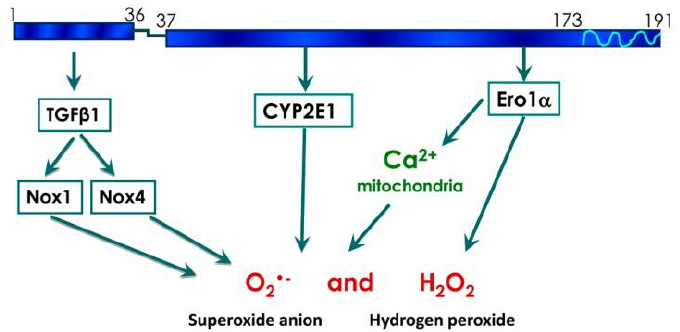
Figure 7. Proposed model of regulation of oxidative stress by HCV core protein.